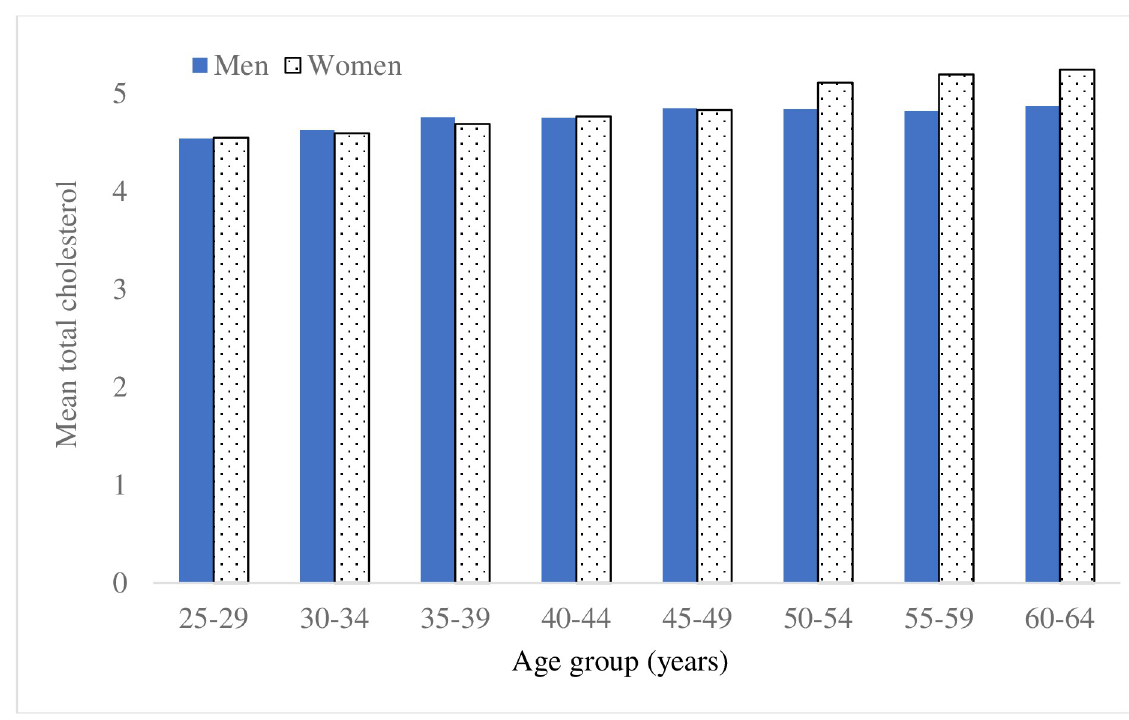
Fig 1. Mean of total cholesterol by age group and